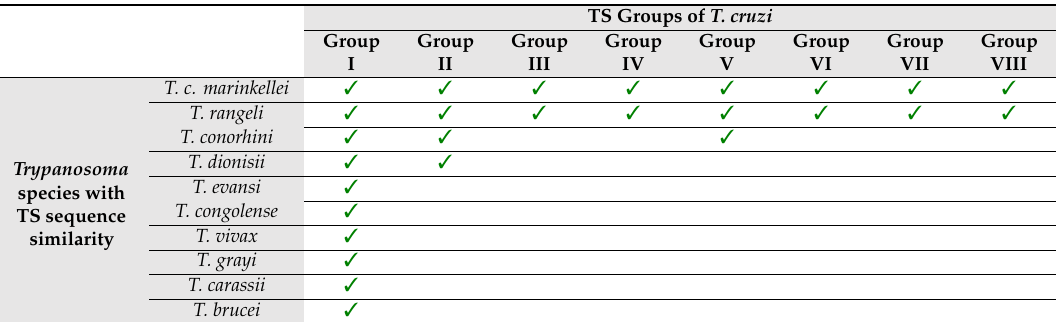
Table 2. Presence of at least one member of each TS group in di ff erent Trypanosoma species.